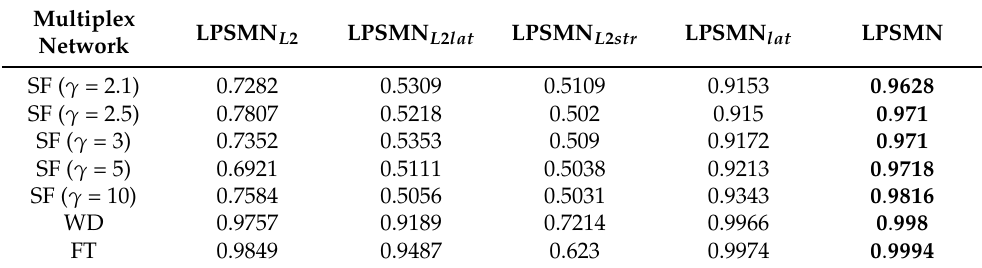
Table 4. Ablation study of LPSMN with the combination of different features and